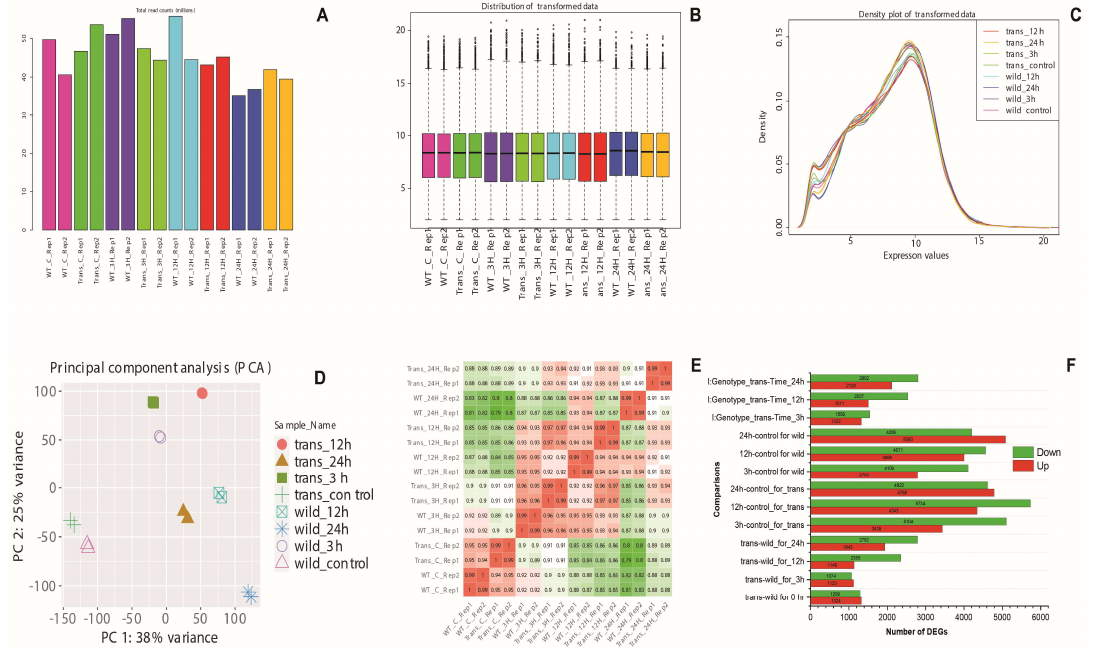
Figure 1. ( A ) Total read count per library; ( B ) boxplot of transformed data; ( C ) distribution of transformed data using a density plot; ( D ) PCA analyses indicate the substantial difference in thousands of genes induced by WBPH in OxF3H and wild plants, ( E ) Correlation matrix: results of the correlation analysis displayed in matrix format. Each row and each column represents a single sample. Colored cells indicate the correlation value between the row and column sample based on the read count for each gene. Green colors indicate lower correlation, and red colors indicate higher correlation; ( F ) statistics of DEGs (upregulated and downregulated) gene count comparisons of “ OxF3H ” vs. “Wild” at different times of infection for each comparison by using Deseq2. I:Genotype_trans-Times represent the number of genes whose expression was significantly affected by the interaction between genotype and time in OxF3H